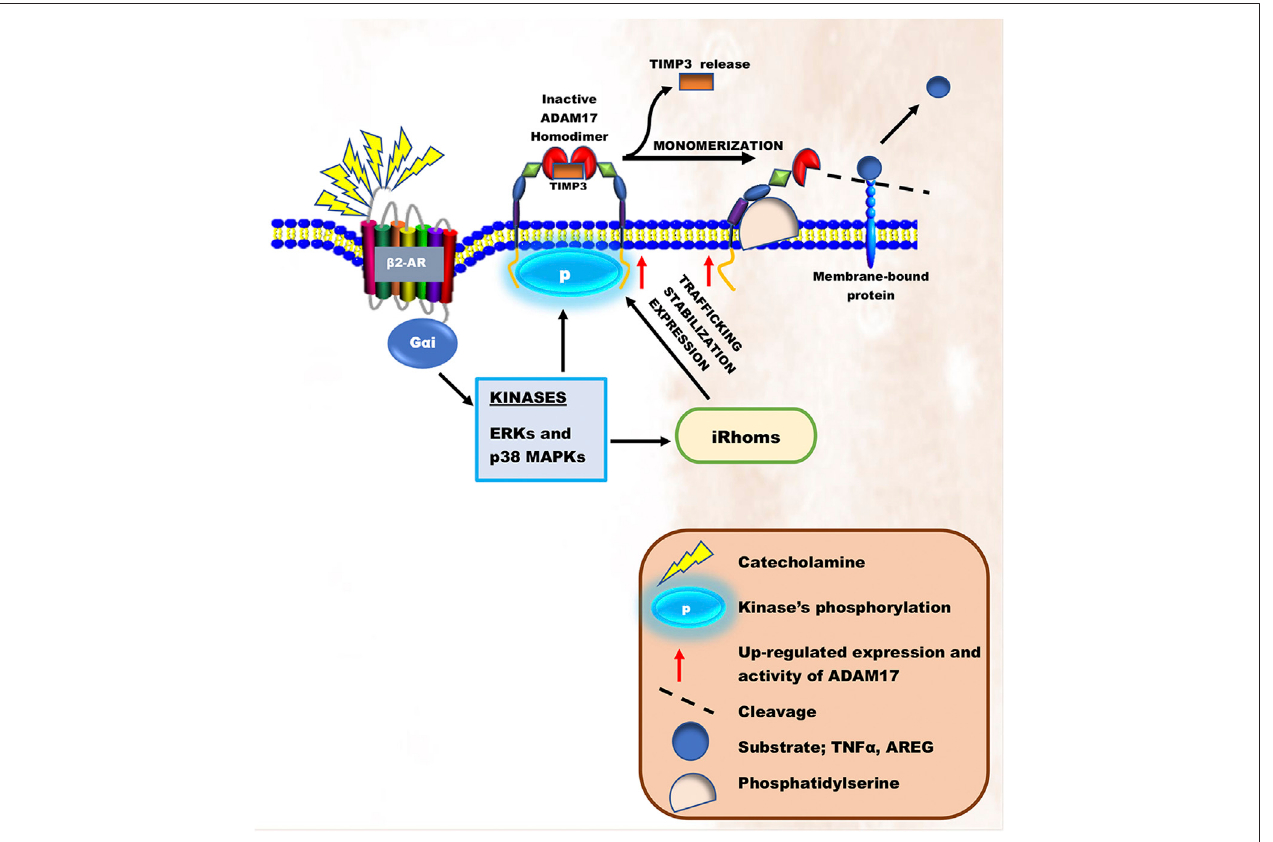
FIGURE 2 | Schematic illustration of ADAM17 ’ s activation during chronic catecholamine stress. Elevated catecholamines owning to chronic stress results in overstimulation of β 2-ARs coupling with G α i. G α i signaling induces the activation of intracellular kinases, ERKs and p38 MAPKs. These kinases are known to either directly phosphorylate and activate ADAM17 or activate iRhoms responsible for traf fi cking, stabilization, and cell surface expression of ADAM17, thereby initiating its cleaving process.